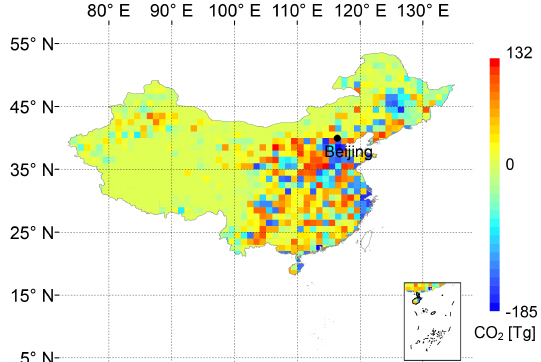
Figure 3. Difference of annual total anthropogenic CO 2 emissions between CHRED and ODIAC in 2012 in China, where the black dot represents Beijing, the capital of